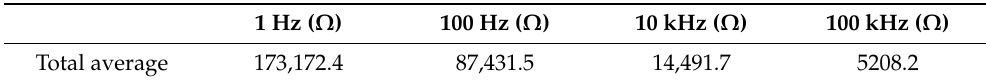
Table 8. Total average data for the corresponding